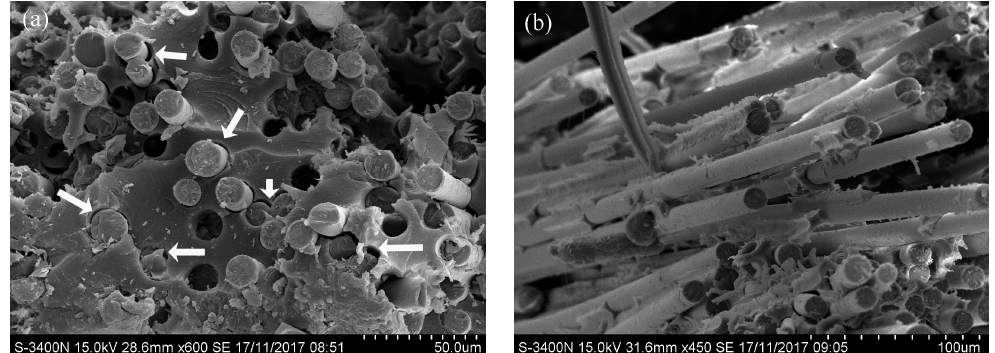
Figure 11. The morphologies of the BFRP sheets exposed for 180 cycles, ( a ) interface; ( b ) fiber.